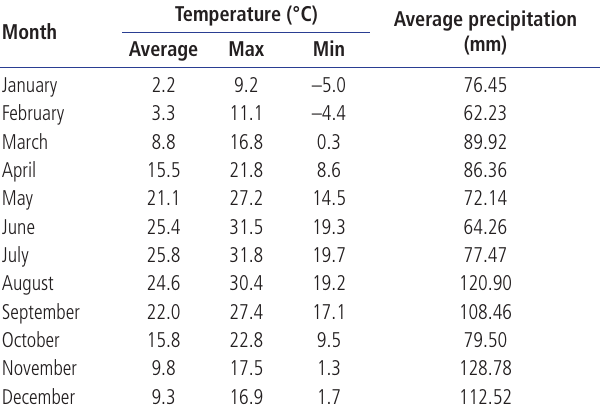
Table 1. Basic monthly meteorological information for North Carolina